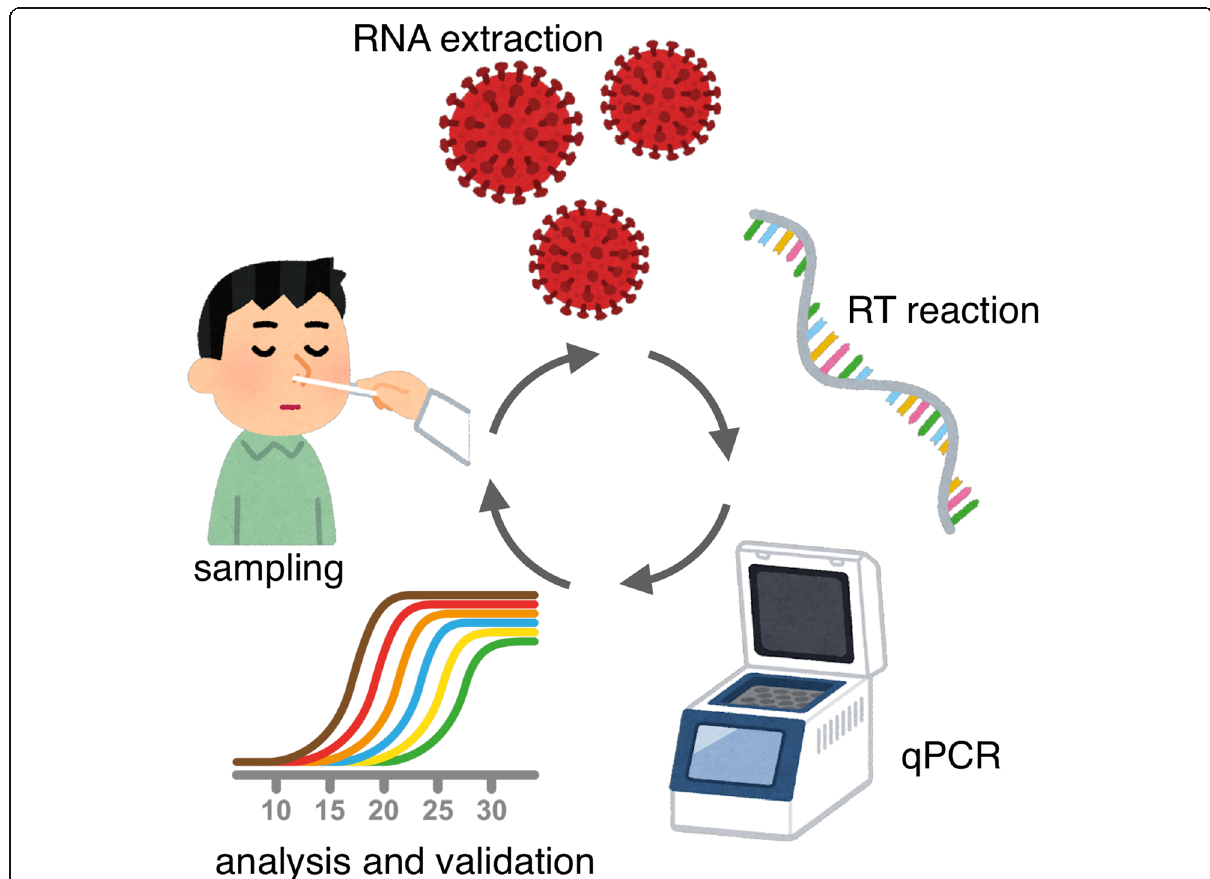
Fig. 2 Schematic of workflow of an in-house RT-qPCR-based assay for detecting SARS-CoV-2, showing each step from patient sampling to reporting of results. A sample is collected from the patient ’ s nasopharynx, saliva, or other tissues. RNA is extracted from the sample and then transcribed into cDNA (RT reaction). DNA polymerase amplifies the cDNA, degrading fluorescent probes which results in an increased fluorescence intensity (qPCR). If the intensity reaches a certain threshold, the sample is classed as